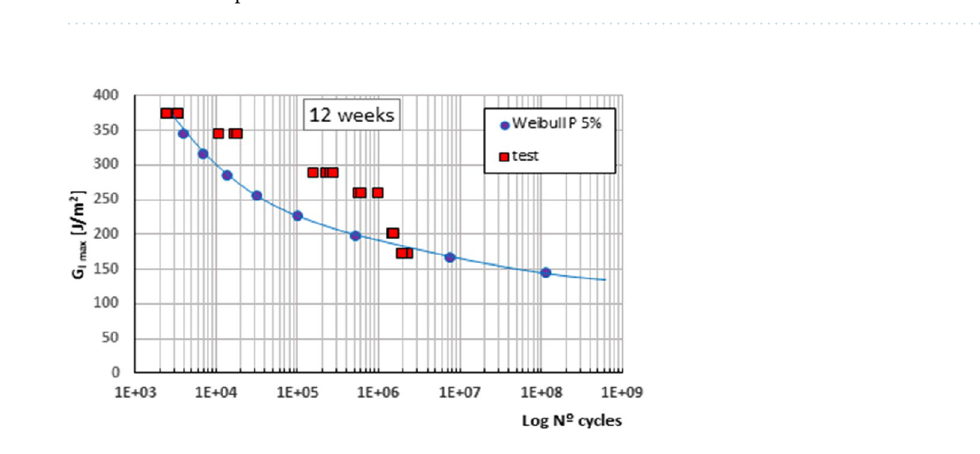
Figure 3. Fatigue initiation curves of material under mode I fracture, for 5% probability of fracture, material under 1 week of exposure.